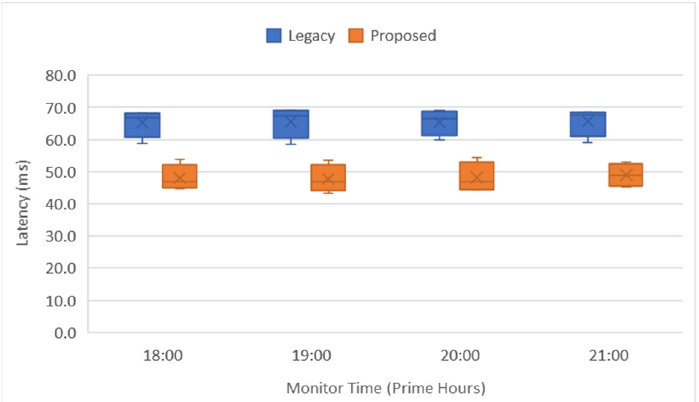
Figure 17. Border leaf switch latency—All week comparison. Table 6. Legacy vs. proposed latency comparison